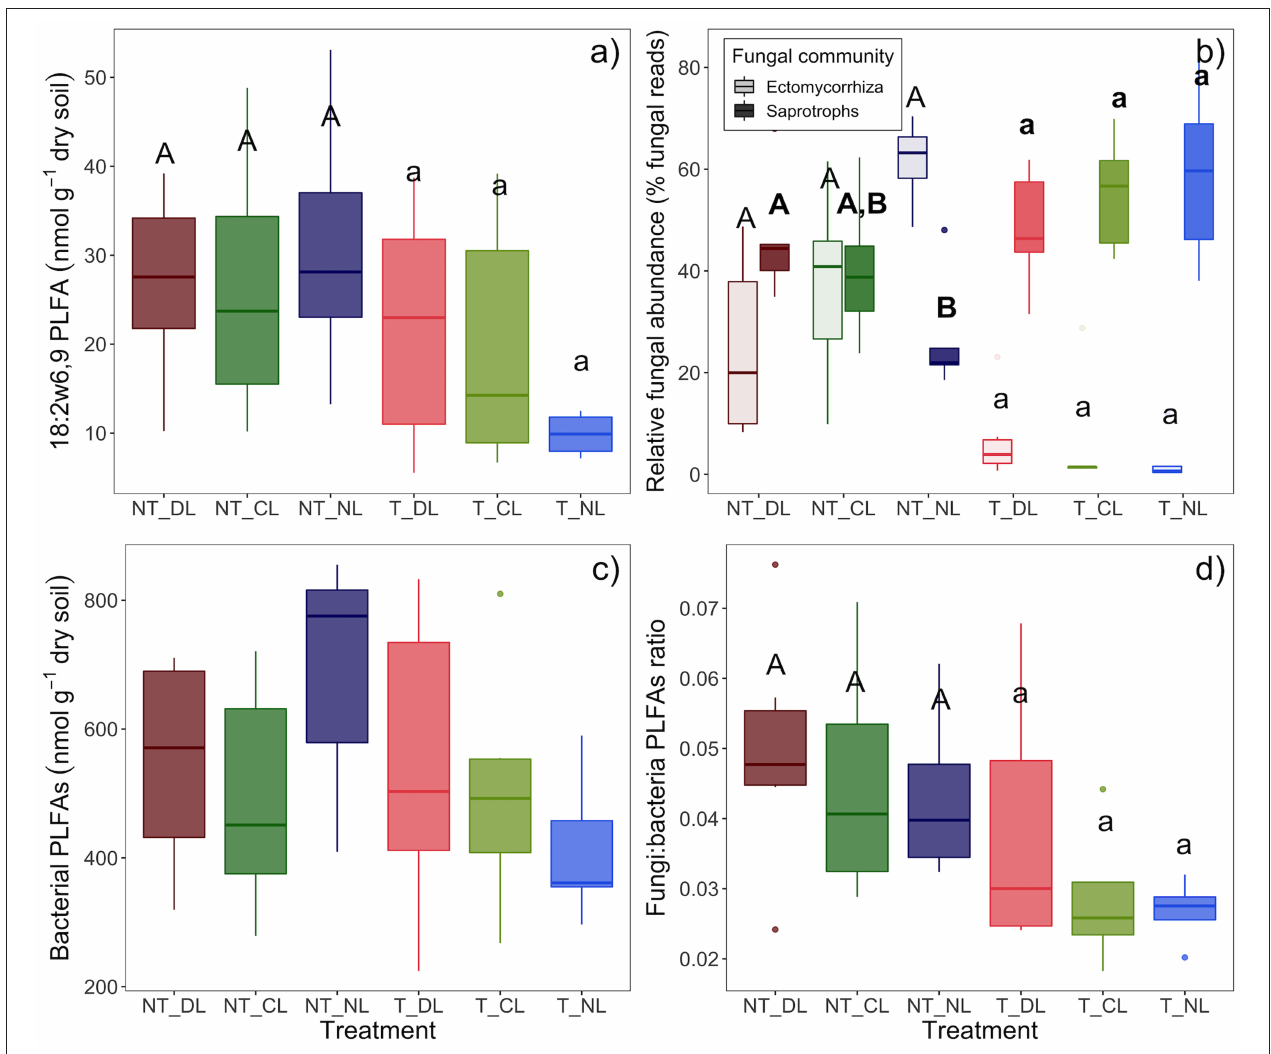
FIGURE 4 | Abundance estimations of soil microbial groups in the trenching and leaf litter inputs treatments. (a) 18:2 ω 6,9 PLFA marker (fungal abundance), (b) relative abundances of saprotrophic and ectomycorrhizal fungi (% of fungal DNA reads), (c) sum of bacterial PLFAs, (d) ratio of fungal to bacterial PLFAs. Box-plots represent the values of n = 5 plots per treatment. Different letter case indicates significant effect of trenching according two-ways ANOVA, different letters indicate significant differences among leaf litter input levels within each trenching level according one-ways ANOVA. In (b) , bold letters indicate treatment effects on saprotrophic fungi and normal letters indicate treatment effects on ectomycorrhizal fungi. NT_DL, Non-Trenched and Doubled Litter; NT_CL, Non-Trenched and Control Litter; NT_NL, Non-Trenched and No-Litter; T_DL, Trenched and Doubled Litter; T_CL, Trenched and Control Litter; T_NL, Trenched and